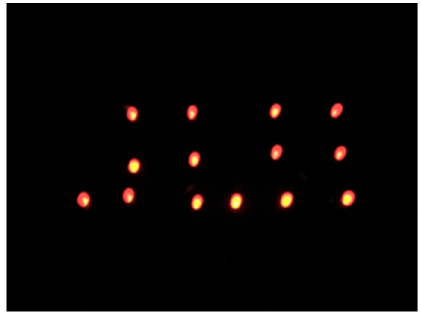
Figure 16. LED darkroom effect.